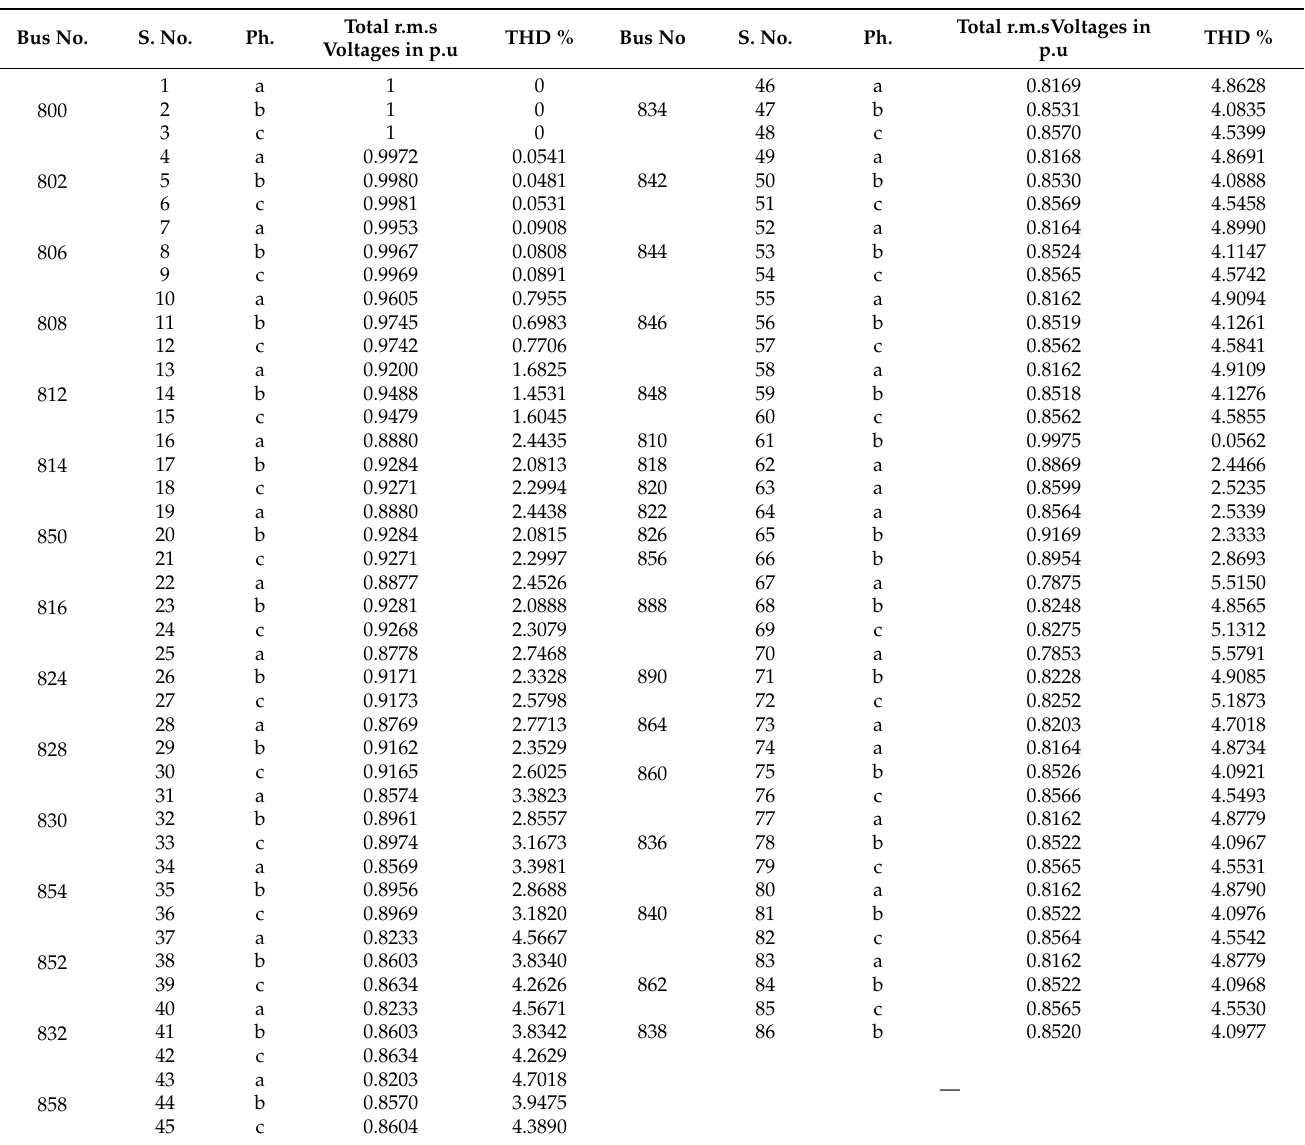
Table 12. Fundamental r.m.s voltages, total r.m.s voltages, and THD % in the IEEE − 34 bus URDN for Case 1. Bus No. S. No.